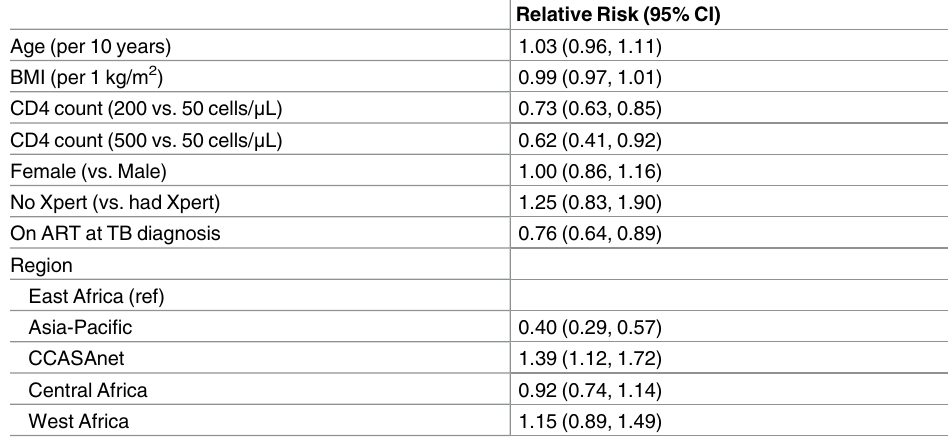
Table 5. Multivariable modified Poisson regression analysis of factors associated with an unfavor- able TB treatment